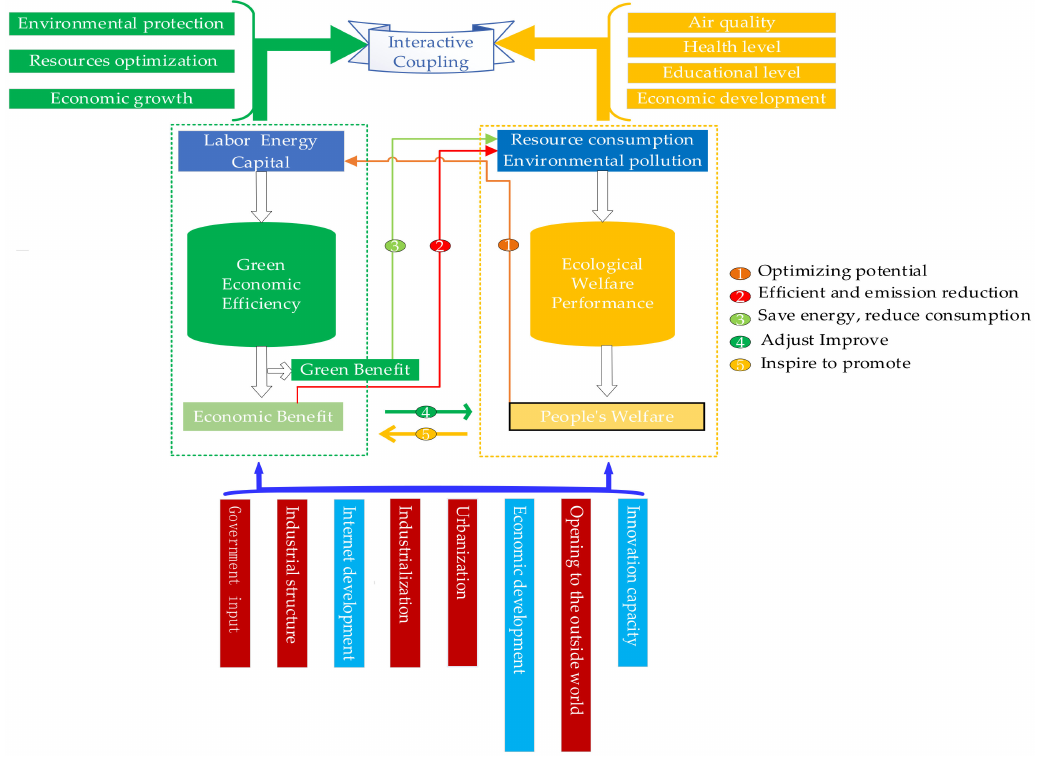
Figure 1. The coupling and driving mechanism of green economic efficiency and ecological welfare